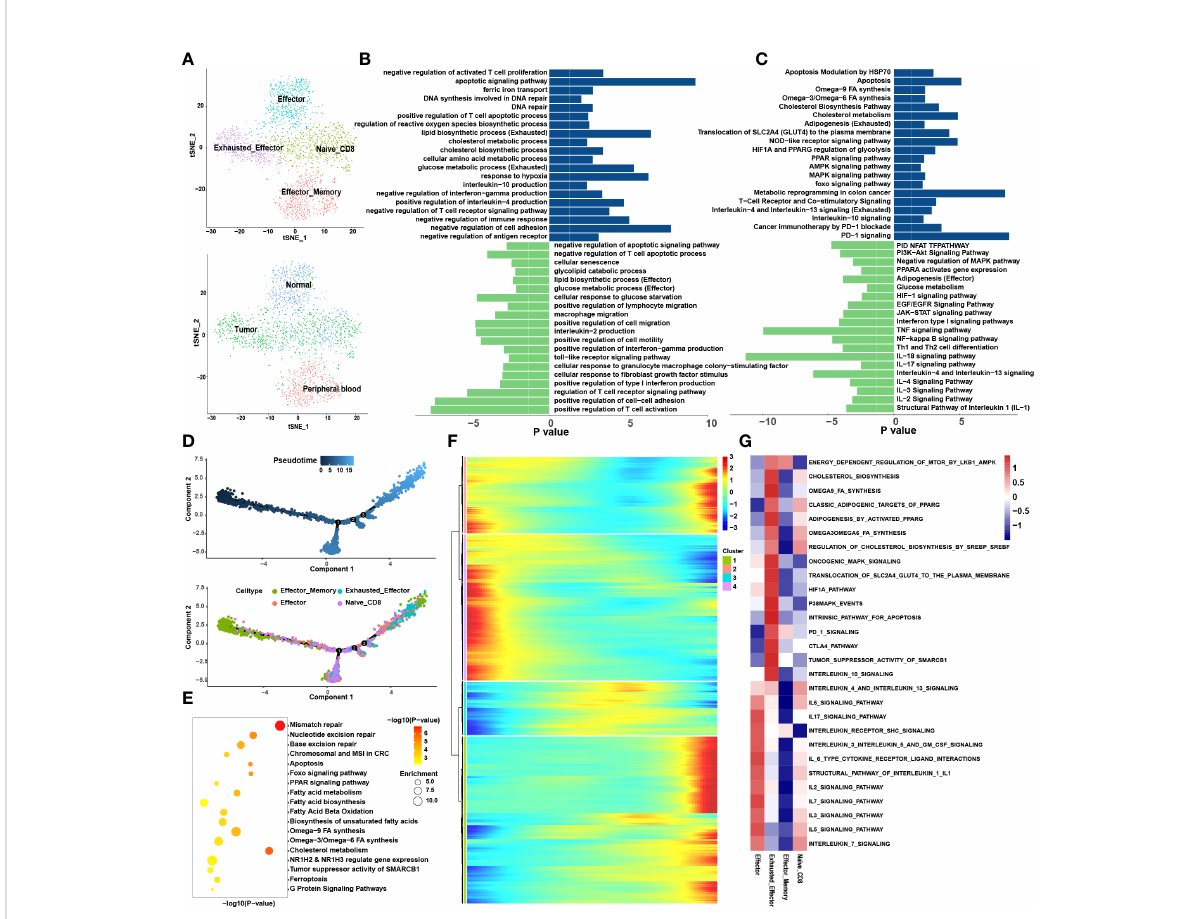
FIGURE 2 CD8+ T cells tend to exhaust in the tumor microenvironment. (A) tSNE plots showing 4 sub-cell types of CD8+ T cells (upper) and their tissue origins (lower). (B) GO and (C) KEGG pathway enrichment analyses of marker genes of Tex (blue color) and Teff (green color). The height of each barplot shows the log10 of P-value calculated using the Metascape database. (D) Differentiation trajectory of CD8+ T cells in CRC, color- coded for pseudotime (upper) and sub-cell types (lower). (E) Pseudo-heatmap of genes altered in the differentiation process of CD8+ T cells in CRC, divided into four clusters. (F) The bubble plot shows the GO and KEGG pathway enrichment analysis of genes in cluster 1 identi fi ed in Pseudo-heatmap using the Metascape database. (G) The heatmap illustrates the activity of biological process and signaling pathway in each cell type by